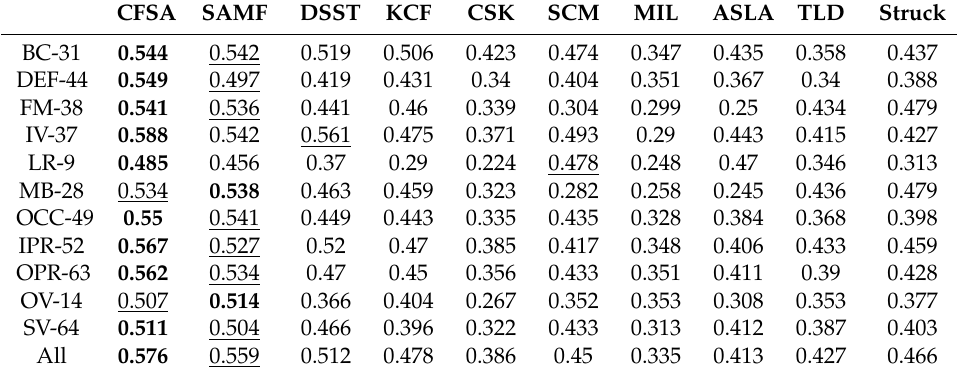
Table 4. The success plot’s AUC scores of CFSA tracker and nine other state-of-the-art trackers on the OTB-100 dataset. Bold and underline values indicate best and second performances, respectively. CFSA SAMF DSST KCF CSK SCM MIL ASLA TLD Struck